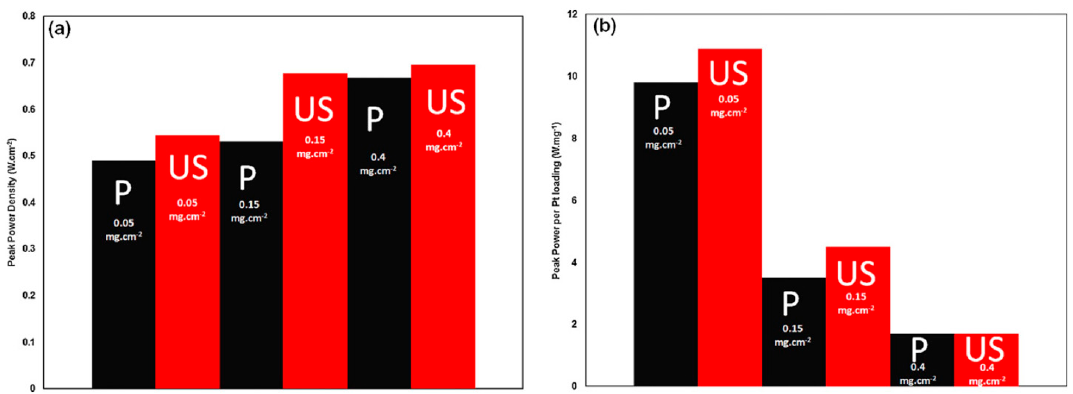
Figure 16. SEM images: ( a ) top view and ( b ) cross-section of the catalyst layer prepared by the ultrasonic-spray method. Pt loading: 0.40 mg cm − 2 on Sigracet 10BC GDL, ( c ) top view and ( d ) cross-section of catalyst layer (CL) prepared by the US technique. Pt loading: 0.15 mg cm − 2 on Sigracet 10BC GDL, ( e ) top view and ( f ) cross-section of CL prepared by US. Pt loading is 0.05 mg cm − 2 on Sigracet 10BC GDL, ( g ) top view and ( h ) cross-section of catalyst layer prepared by hand-painting. Pt loading: 0.40 mg cm − 2 on Sigracet 34BC GDL [27].